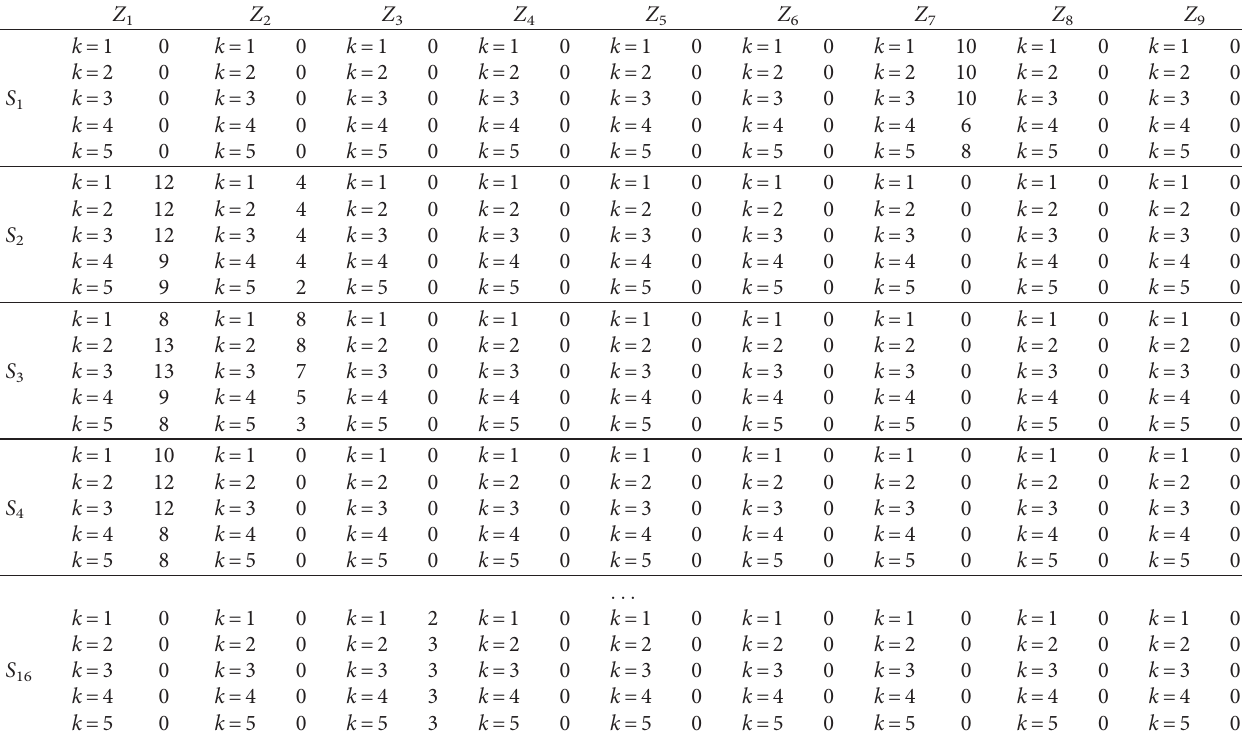
Table 11: Frequency distribution of staff in different parking lots.